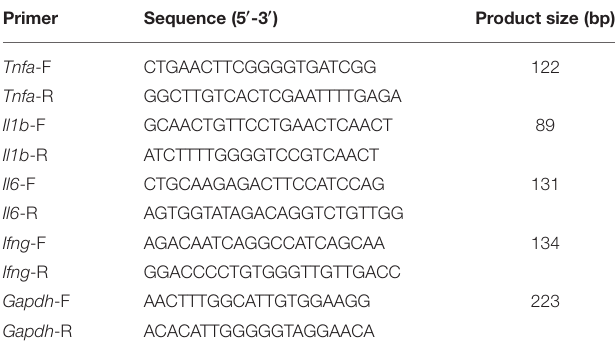
TABLE 1 | Sequences of the primers used in this